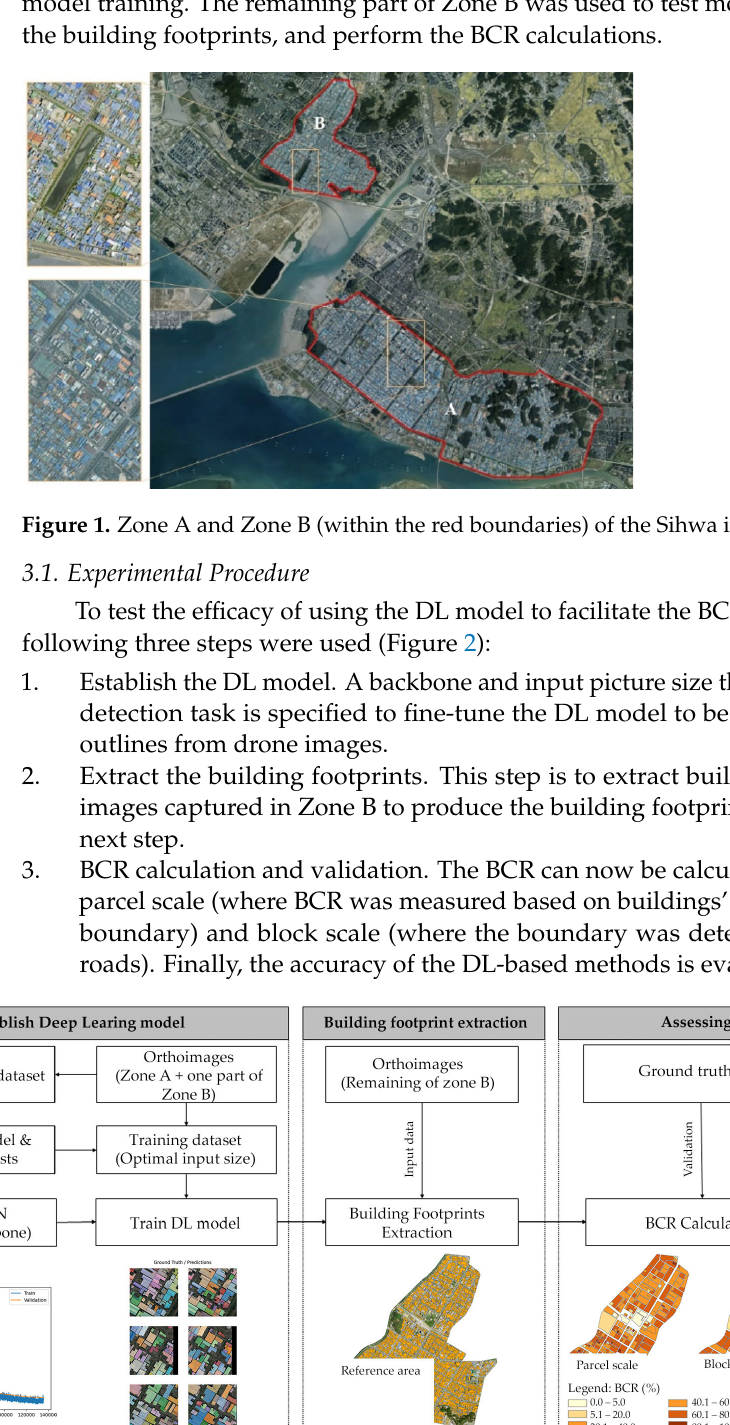
Figure 2. The experimental procedure.